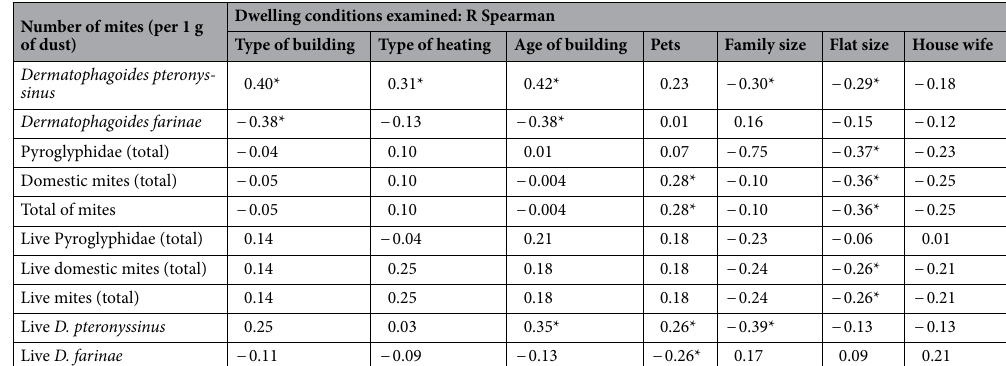
Table 3. Relationships observed between housing conditions and the prevalence of mites in dust samples from dwellings of the examined patients in Bytom (south Poland). Results of the Spearman’s rank correlation test analysis (*p < 0.05). Part I. Type of building: block of houses [1], tenement-house [2], brick house (old) [3]; Type of heating: central [1], electric/gas/oil [2] or coal-stove [3]; Age of building: in years; Pets: no pets [0], fish/reptilians [1], birds [2], mammals (cats, dogs, hamsters, rabbits) [3]; Family size: number of inhabitants; Flat size: area occupied by each flat (surface in square meters); House wife: not employed [1], employed